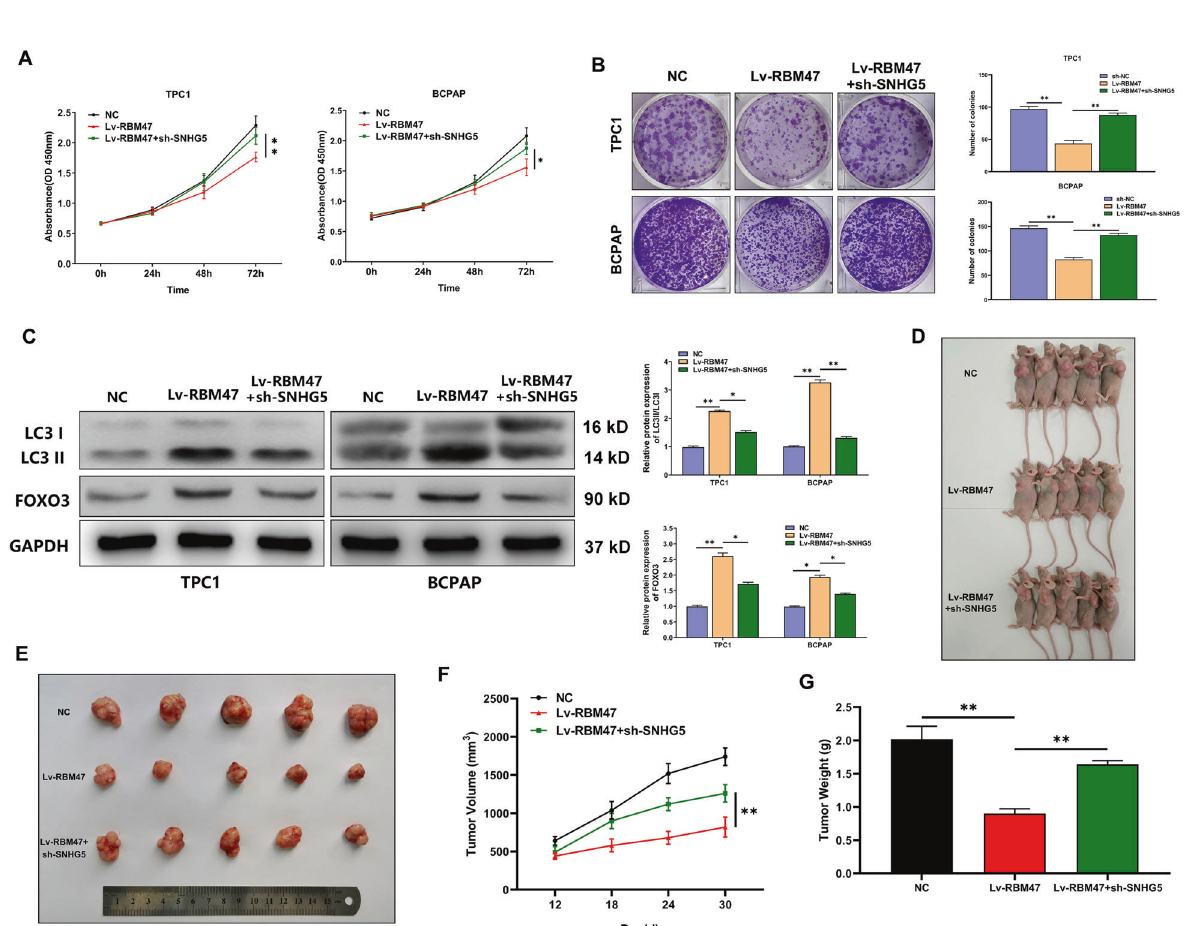
Fig. 4 RBM47 regulates PTC cell proliferation and autophagy via SNHG5 in vitro and in vivo. A , B Proliferation of PTC cells transfected with sh-NC, Lv-RBM47, or Lv-RBM47 + sh-SNHG5 evaluated by CCK-8 assay and plate colony assay. C LC3 II/LC3 I ratio and FOXO3 protein level detected by WB in PTC cells transfected with sh-NC, Lv-RBM47, or Lv-RBM47 + sh-SNHG5. D , E The subcutaneous implant mouse models inoculated with sh-NC, Lv-RBM47, or Lv-RBM47 + sh-SNHG5 TPC1 cells ( n = 5). F , G Volumes and weights of harvested tumors in both groups. Scale bar = 20 μ m. Statistical differences were analyzed using the independent samples t-test; data are shown as the mean ± standard error of the mean based on three independent experiments. * p < 0.05, ** p <